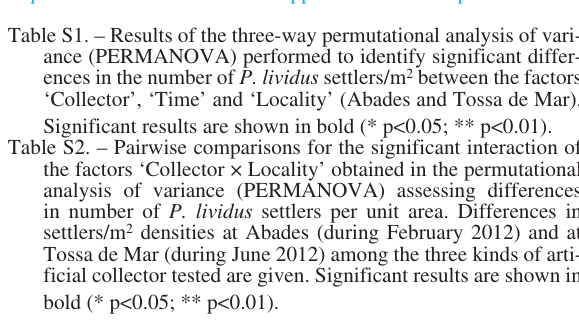
Table S3. – Results of the two-way permutational analysis of vari- ance (PERMANOVA) performed to identify significant differ- ences in the number of A. lixula settlers/m 2 between the factors ‘Collector’ and ‘Time’ at the Canary Islands site (Abades). Significant results are shown in bold (* p<0.05; ** p<0.01). Table S4. – Pairwise comparisons for the significant factors ‘Col-